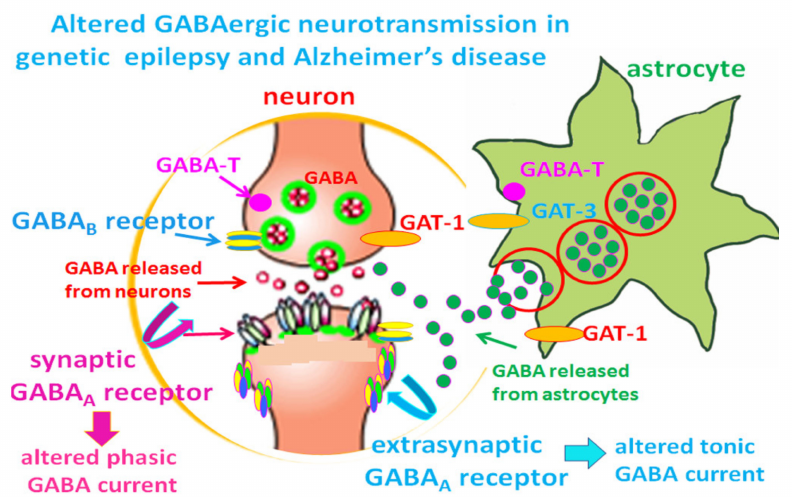
Figure 1. Altered GABAergic neurotransmission in both genetic epilepsy and Alzheimer’s disease. The neurotransmitter GABA can be released from both neurons and glia. GABA is synthesized from glutamic acid, the principal excitatory neurotransmitter via glutamic acid decarboxylase (GAD). GABA is catabolized by GABA transaminase (GABA-T), which is a membrane-bound enzyme expressed by neurons and glia. In GABAergic interneurons, GABA is released from vesicles in presynaptic terminals and activates GABA receptors, which include GABA A receptors and GABA B receptors. Under pathological conditions, such as AD, GABA can also be released from reactive astrocytes. GABA A receptors hyperpolarize neurons via Cl − influx. The released GABA is taken up by GABA transporters (GAT-1 and GAT-3) back into presynaptic compartments of neurons or into astrocytes. Failure of GABA clearance due to malfunctioning GABA transporters or excessive GABA production by reactive astrocytes will alter GABAergic neurotransmission, leading to a seizure-prone brain state